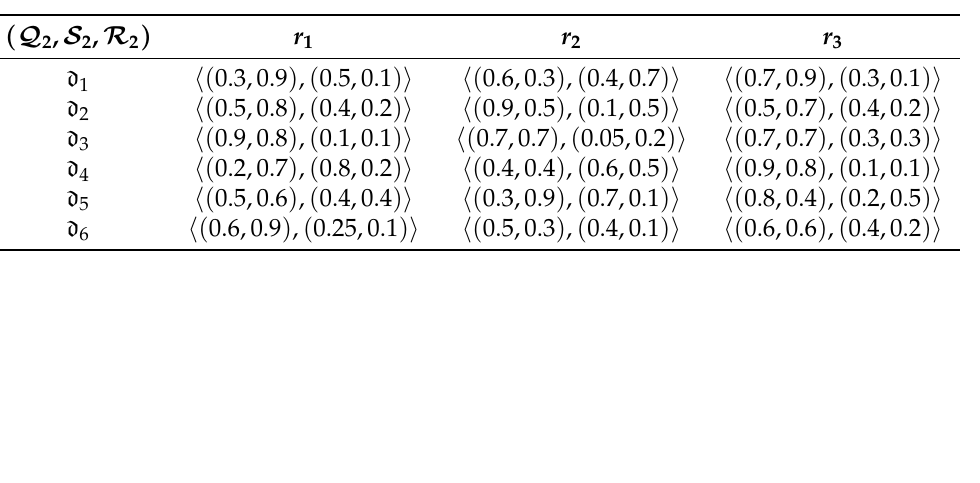
Table 10. Table for the 7-ROFBSS ( Q 2 , S 2 , R 2 )